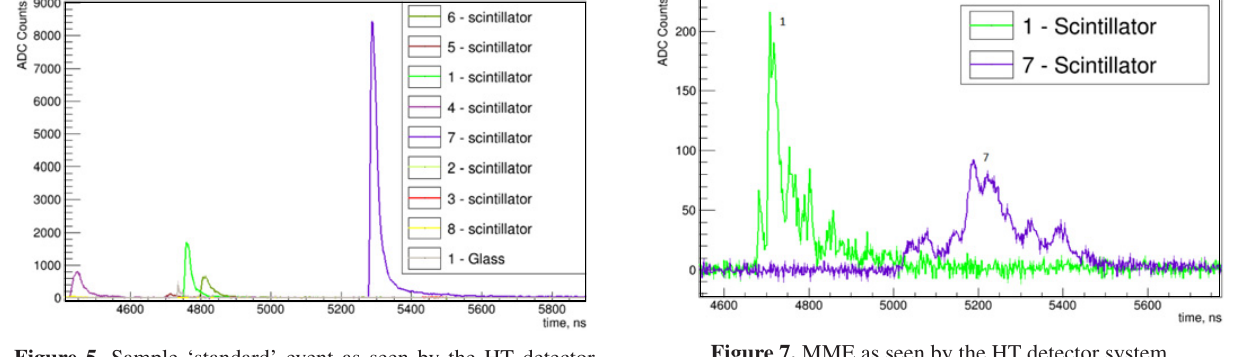
Figure 7. MME as seen by the HT detector system.